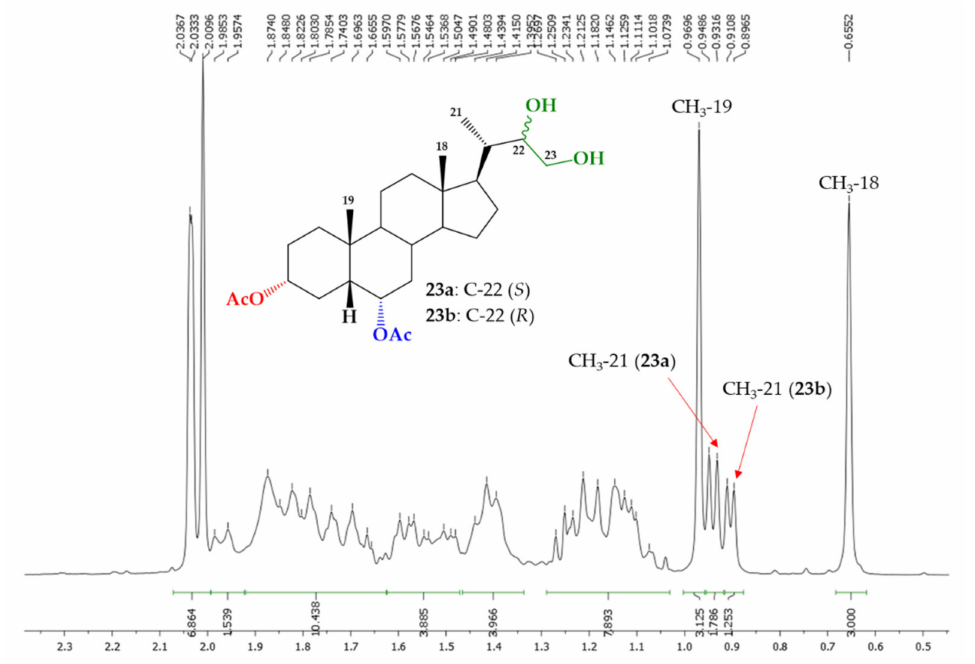
Figure 3. Amplification zone 0.5–2.2 ppm of 1 H NMR of diasteroisomeric mixture 23a / 23b . Benzoylation of glycol mixtures 23a / 23b gives mono- and dibenzoylated derivatives, i.e., compounds 18 - 20 (Scheme 1). Compounds 18 and 20 were purified by C.C. and recrystallized, giving yields of 11.3% and 9.1%, respectively, whereas monobenzoylated derivative 19 could not be isolated in pure form. Additionally, a mixture of monobenzoylated epimers 18 / 19 were also obtained with 78.2% yield ( 18 : 19 = 1.0:0.44). The proportion of each epimer in the mixture was determined from integration of 1 H NMR signals at δ H = 4.48, 4.39, 4.26 and 4.05 ppm, assigned to H-23a, H-23b and H-22 for 18 and 19 (Figure 4).